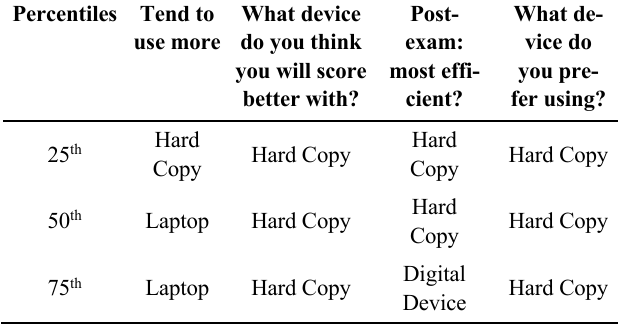
Table 3. Summary of the percentile scores from the